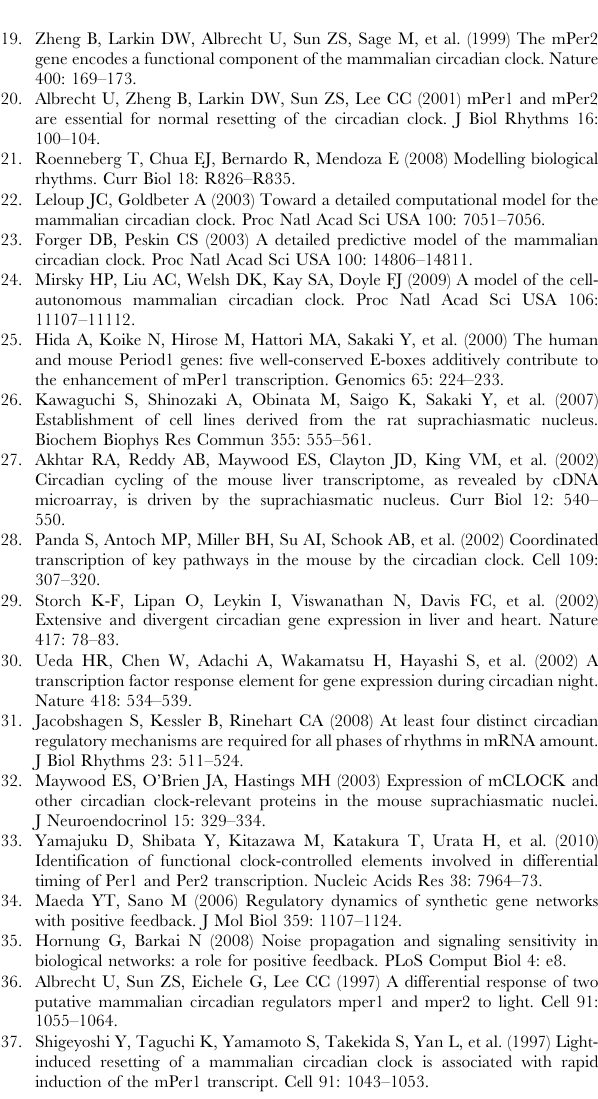
Figure S2 Analysis of the effect of PER positive feedback regulation on expression period and phase. The Per2 mRNA expression phase variation that depended on the intensity of additional PER1/2 positive feedback regulation was